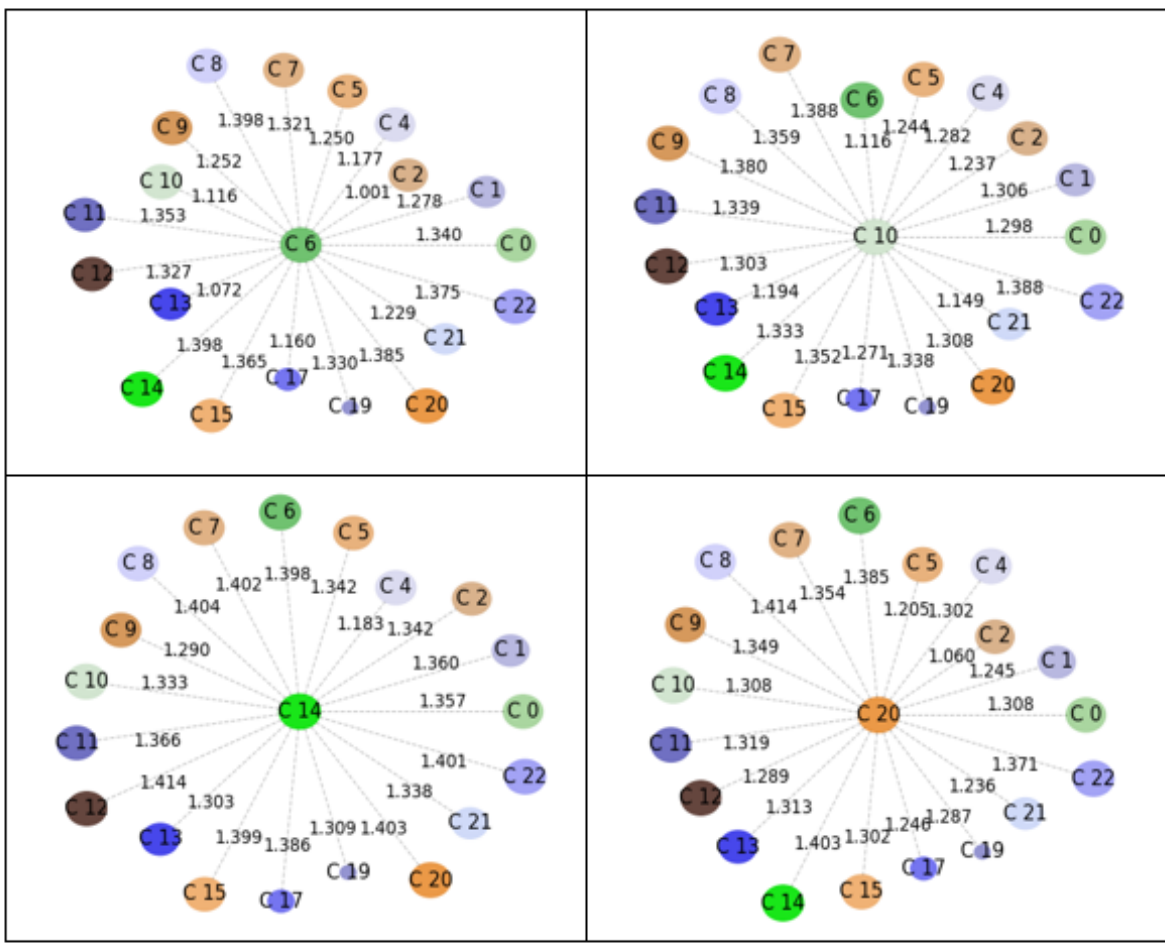
Figure 3. Distance between prominent provaccine clusters and the rest of the